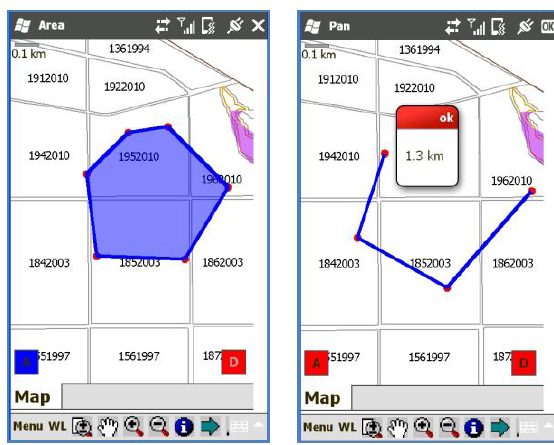
Figure 10. Editing geometries of existing features  Area and distance measurements: Areas of polygon or length of line features surveyed/mapped in the field can also be estimated using this functionality. This enables the user to immediately determine changes in the extent or length of a feature.